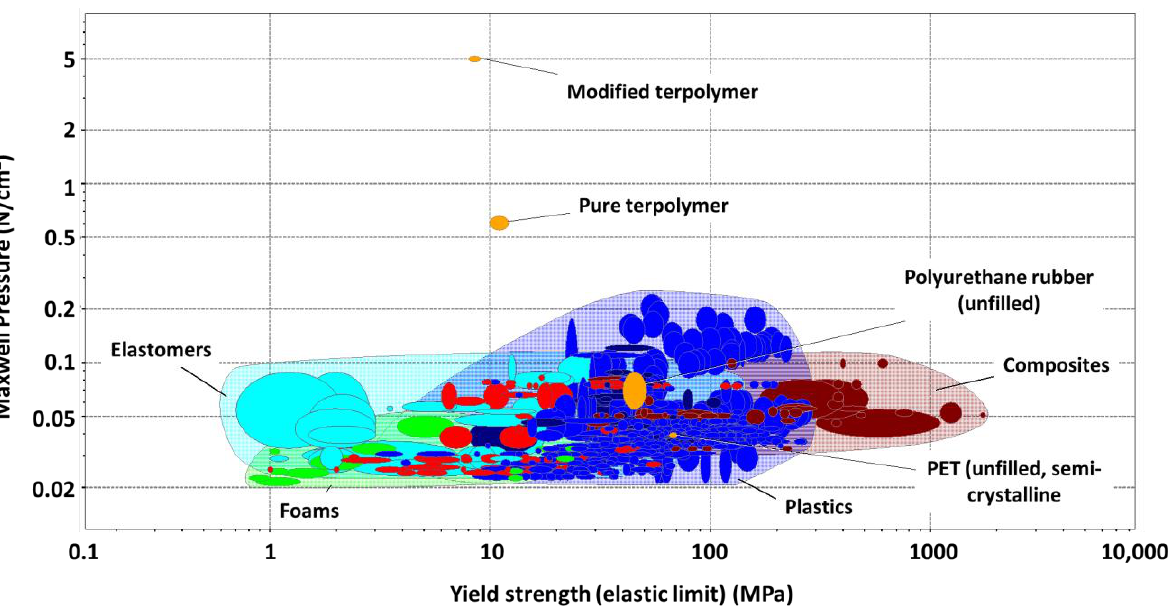
Figure 9. Maxwell pressure at 5 V/ µ m versus elastic limit for polymer and composite materials— studied materials are highlighted in orange.